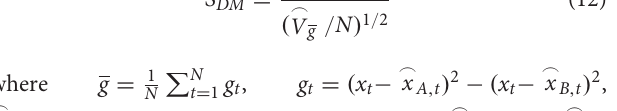
TABLE 3 | Comparison of prediction results of all the models. Model SPIA